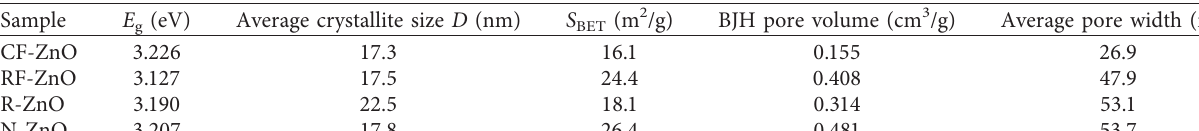
Figure 2: XRD patterns of the CF-ZnO, RF-ZnO, R-ZnO, and N-ZnO Table 2: Textural properties of as-prepared ZnO samples.